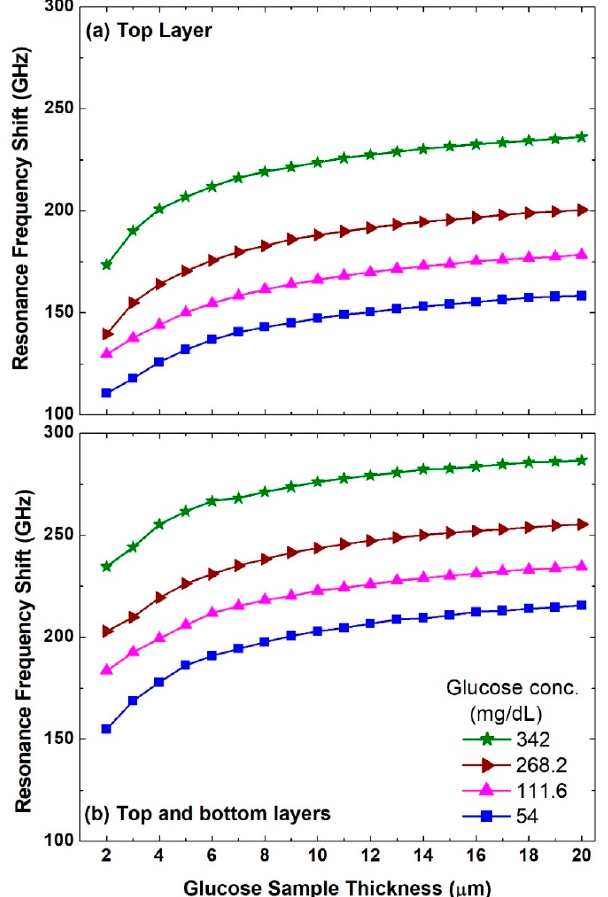
Figure 5. Asymmetric resonance frequency shifts when ( a ) the top layer is considered and when ( b ) the top and bottom layers are considered for different glucose concentration levels and a sweep of glucose sample thicknesses between 2 and 20 µ m.